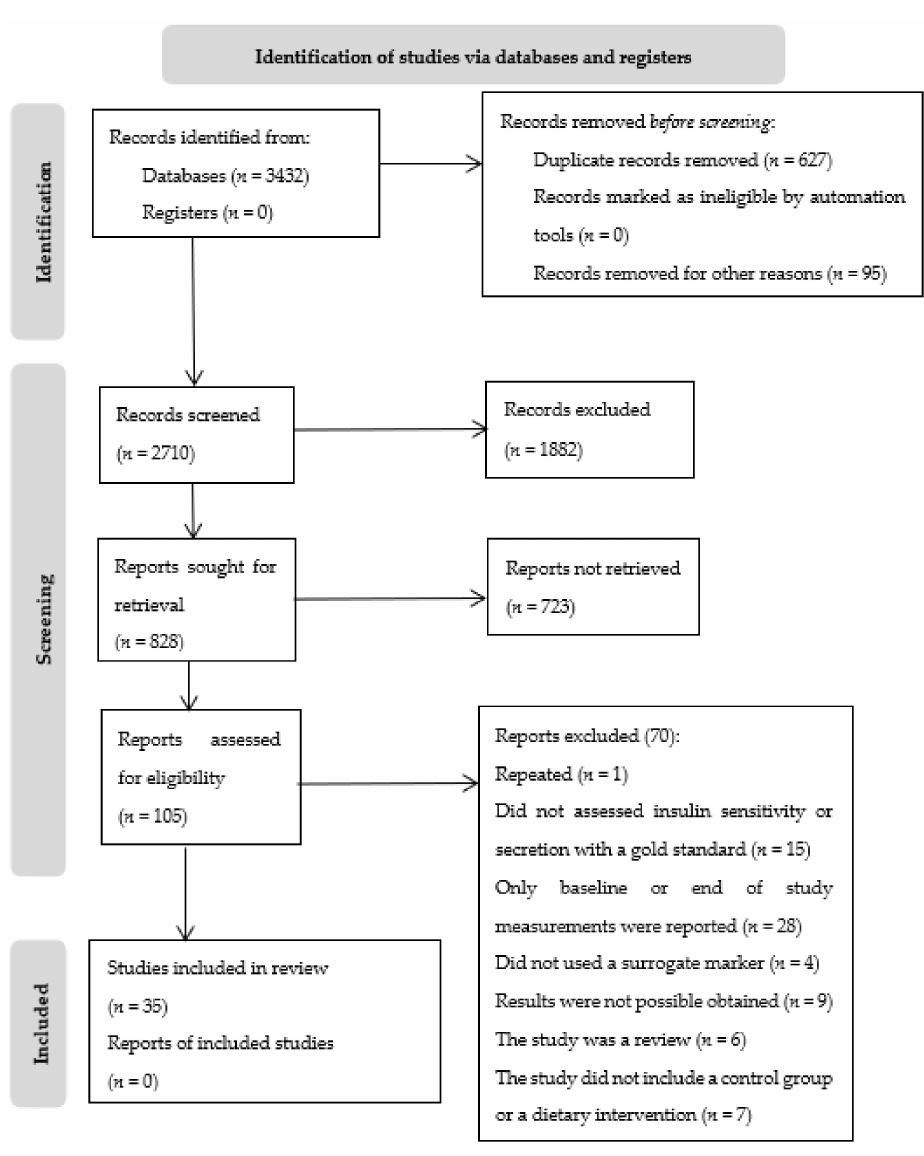
Figure 1. PRISMA flow diagram of study selection for systematic